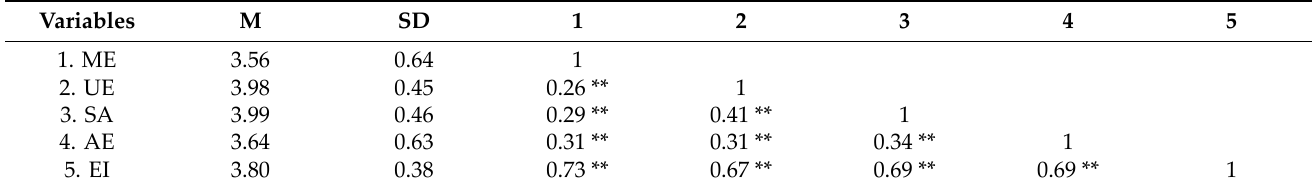
Table 1. Descriptive statistics and correlations between EI and subscales.